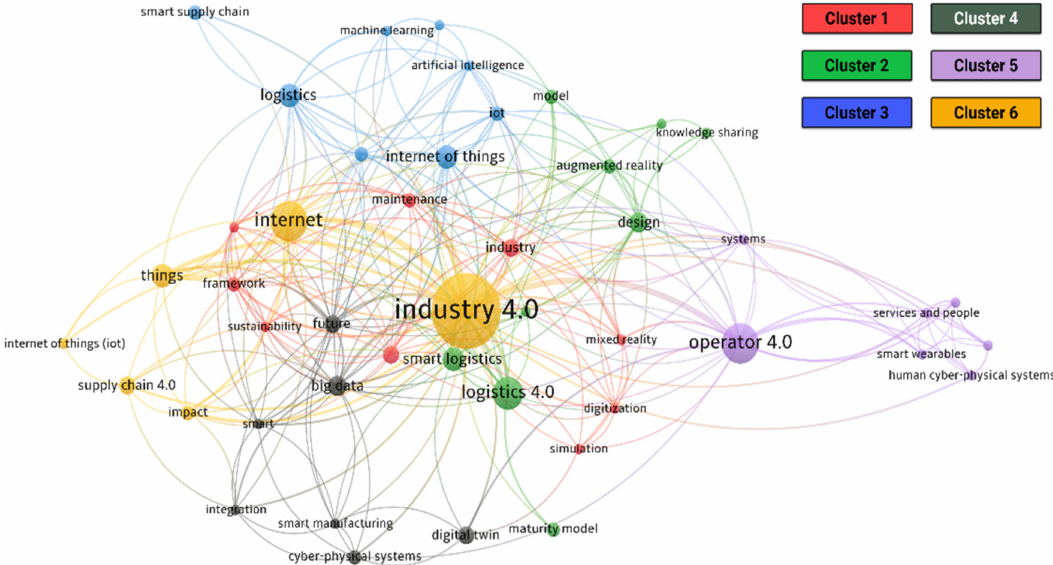
Figure 6. Keyword co-occurrence analysis of smart logistics in Industry 4.0.